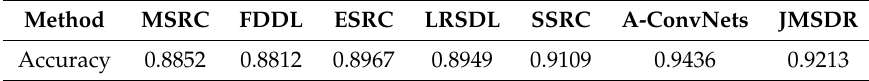
Table 5. The recognition accuracy of different methods under configuration variance EOC-1.